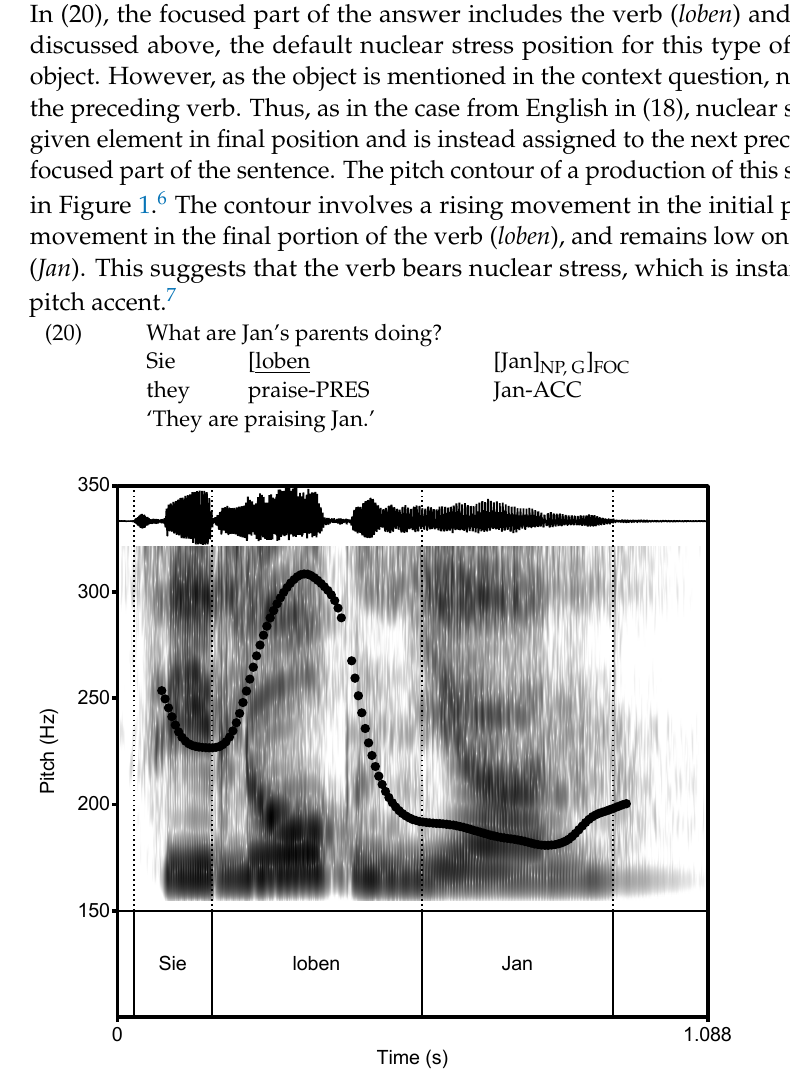
Figure 1. Pitch track, spectrogram, and waveform of a production of the sentence Sie loben Jan ‘They are praising Jan’ (19) where the verb and object ( loben Jan ) are focused and the object ( Jan ) is given.